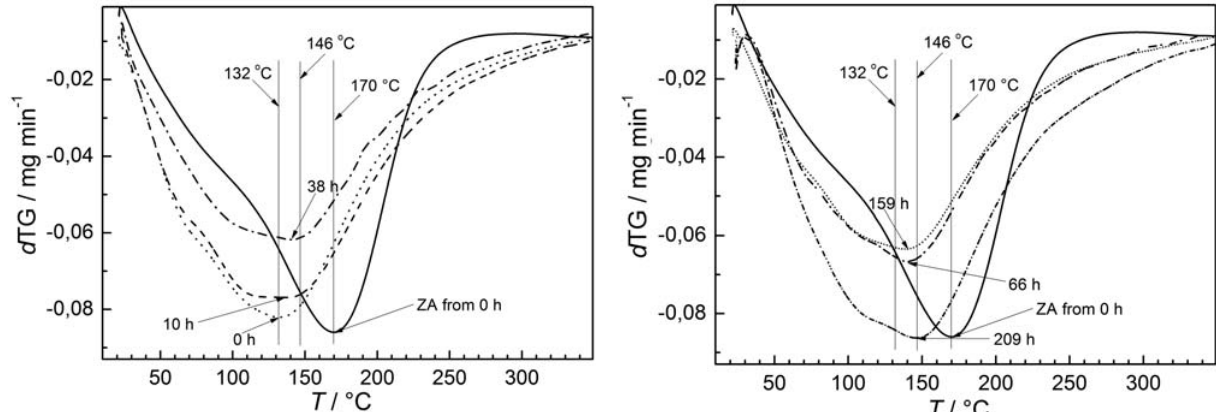
Figure 3. The dTG curves of the gels aged for 0 (dots), 10 (dash), 38 (dash-dot), 66 (dash-dash-dot), 159 (short-dot), 209 h (short-dash-dash-dot) and zeolite A (solid curve) crystals (curve for gel aged 113 h was not shown due to technical problem). Arrows show the minimum at dTG curves.